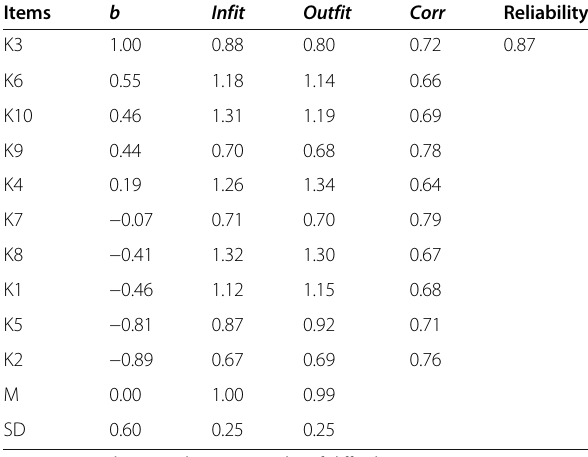
Table 4 Results of the estimation of item parameters in the K10 based on the